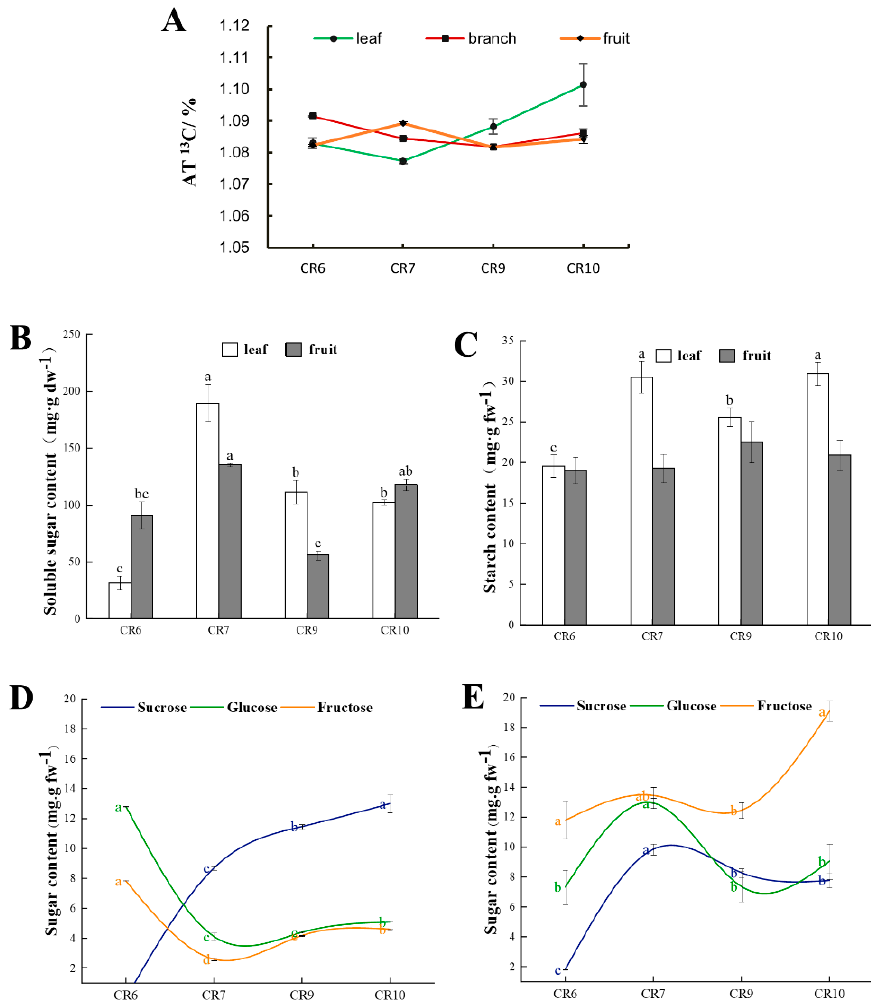
Figure 1. 13 C abundance, starch and sugar content of different Camellia oleifera organs at four developmental stages: CR6, young fruit formation; CR7, fruit expansion; CR9, fruit oil transformation; CR10, fruit ripening. ( A ) The abundance of 13 C in leaves, branches and fruits was measured 72 h after 13 C labeling. The y − axis represents the atomic percentage. ( B ) Soluble sugar content in leaves and fruit. ( C ) Starch content in leaves and fruit. ( D ) Sucrose, glucose and fructose content in leaf. The sucrose content is counted as 0 in CR6 in leaves because it is below the limit of detection by high performance liquid chromatography (HPLC). ( E ) Sucrose, glucose and fructose content in fruit. Significant differences ( p < 0.05) are indicated by lower case letters which are arranged alphabetically starting from the highest values. Similar letters indicates no significant difference. All error bars depict the SD of the mean (n = 3).